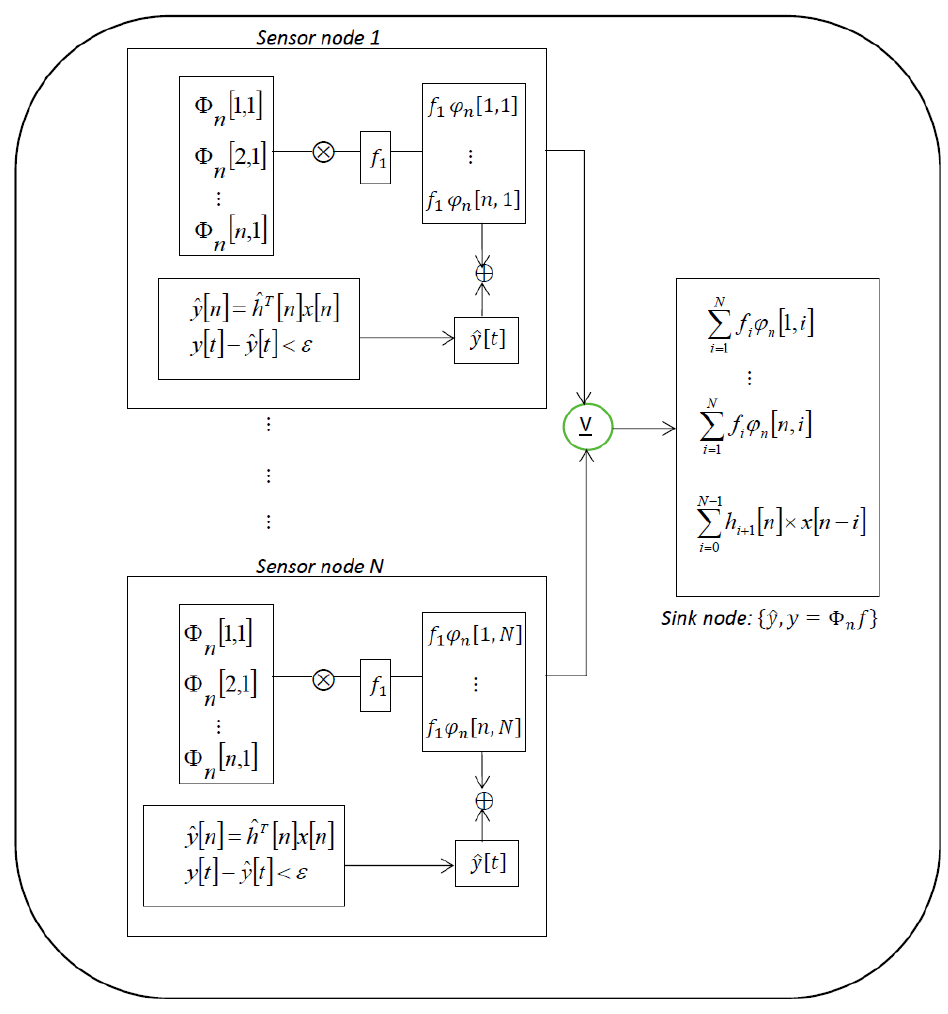
Figure 1. SWIFTNET in a WSN with star